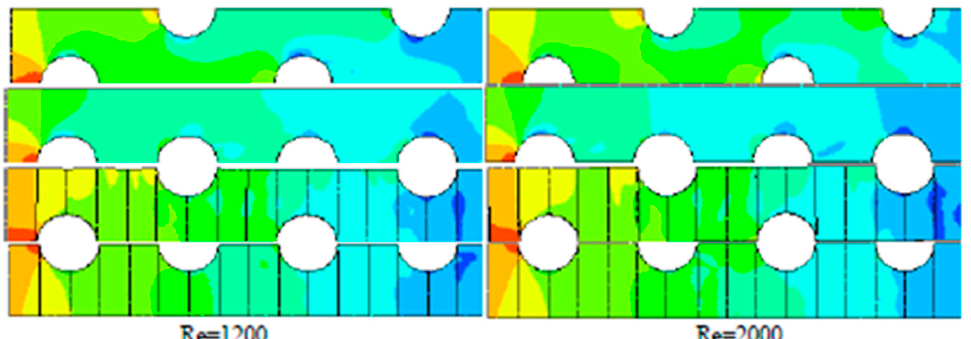
Figure 13. Impact on pressure drop coefficient for different fin configurations [65]. Recent works using CFD techniques mainly concern compound geometries or dif- ferent fin profiles [68–70]. Lee et al. [68] performed an experimental and numerical anal- ysis on wavy fin-and-tube heat exchangers with elliptic tubes and large waffle heights. The influence of different waffle heights, fin pitches, wave lengths, and inlet air velocities on thermo-fluid characteristics was analyzed with the use of CFD techniques and the model was then experimentally validated. In order to assess the effects of both the size and the form of fin perforations on heat transfer capabilities, Rauber et al. [69] computa- tionally and experimentally evaluated heat exchangers with various fin patterns, i.e., rectangular with no insert and rectangular with diamond and circular perforations. Ac- cording